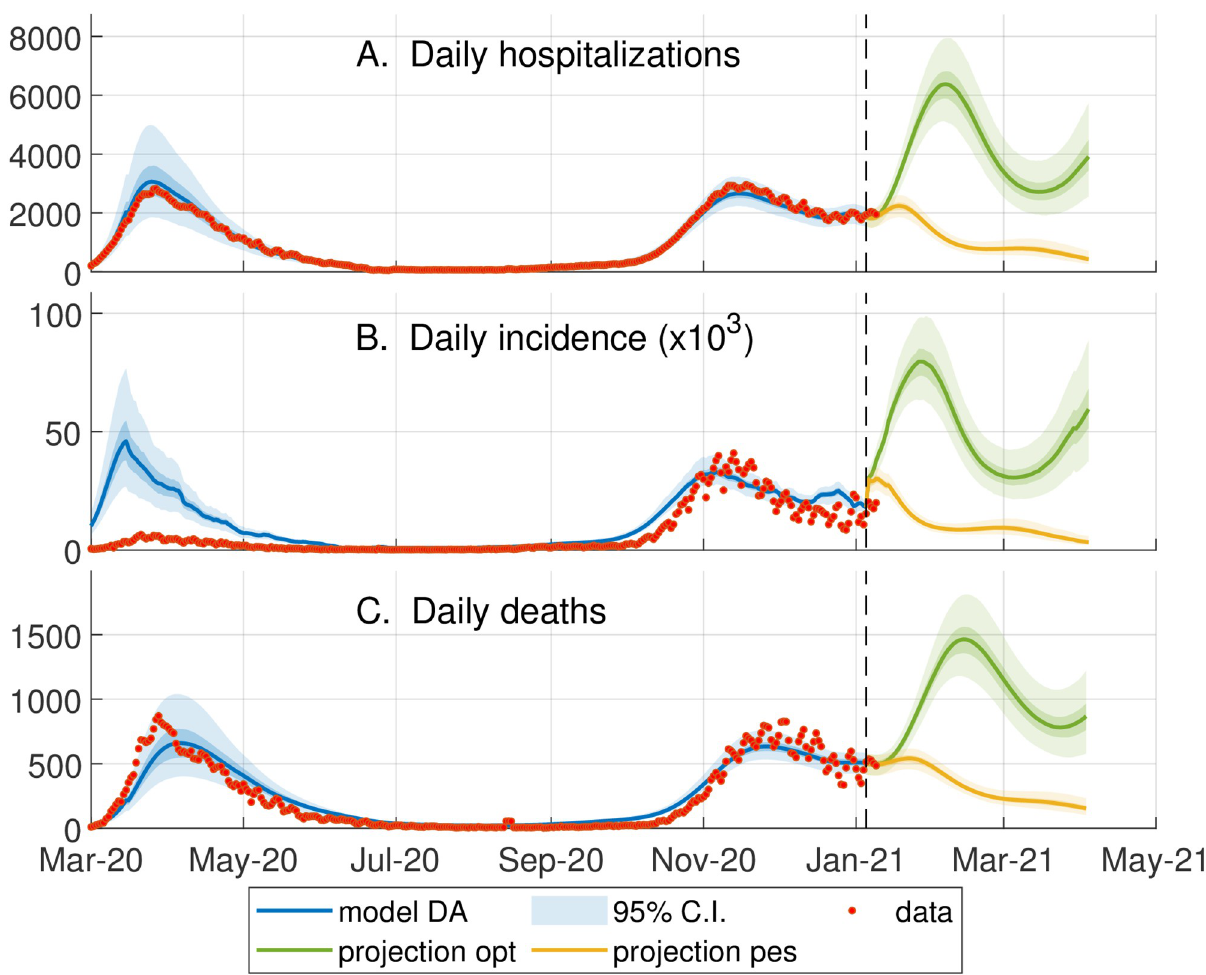
Fig 2. Data assimilation and scenarios for optimization. Comparison between the model outputs (95% confidence interval (CI) of the ensemble, blue shaded area) and the corresponding epidemiological data (red circles, obtained from the bulletins of the Dipartimento della Protezione Civile, https:// github.com/pcm-dpc/COVID-19) from March 2020 to January 2021. The orange and green shaded areas respectively show the ensemble dynamics (95% CI) of what we called pessimistic and optimistic transmission scenarios from January to April. The optimal vaccination strategy in the optimistic (or pessimistic) scenario is computed for the the continuous green (or orange) line, representing the model trajectory obtained using the median of each ensemble parameter. (A) The data on the daily hospitalizations is estimated as described in [9]; this data at the regional level is assimilated on a moving window of 14 days to update the model parameters describing the local transmission rates (see section D in S1 Text). (B) Daily number of newly exposed individuals versus the reported positive cases. Note that the large discrepancy between model and data during the first wave is due to the low testing capacity at the beginning of the epidemic (C) Daily number of